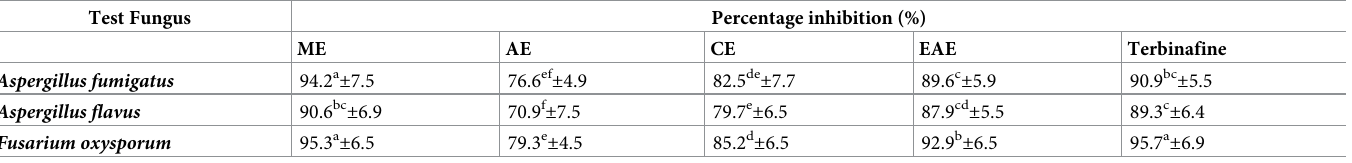
Table 7. Antifungal potential of J . mimosifolia extracts and